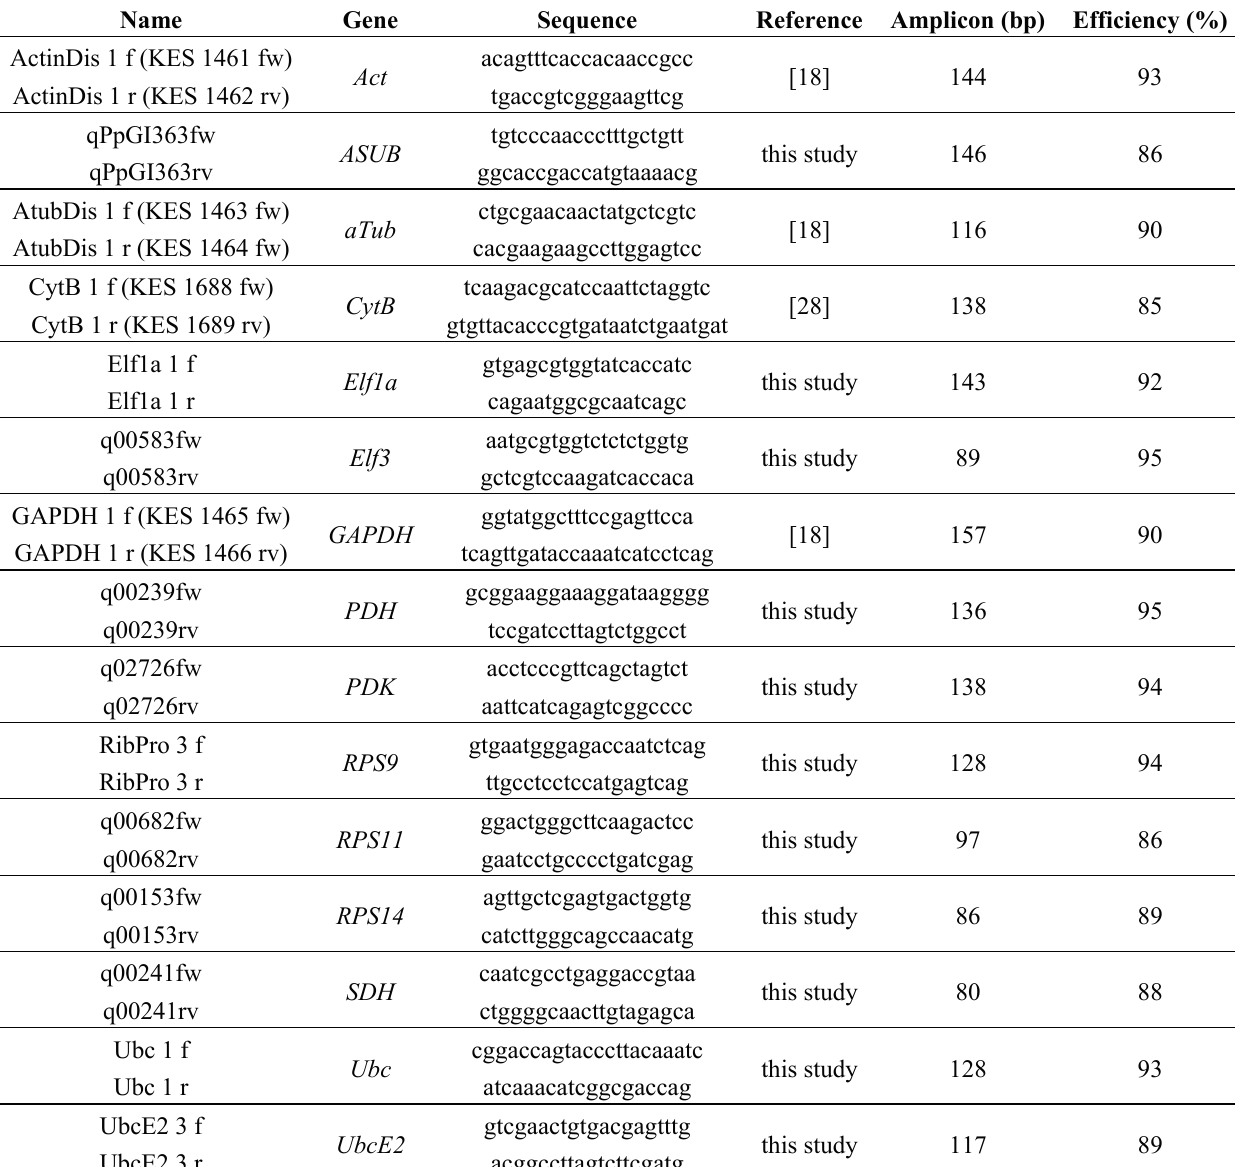
Table 3. Primers used in qRT-PCR for P. pachyrhizi